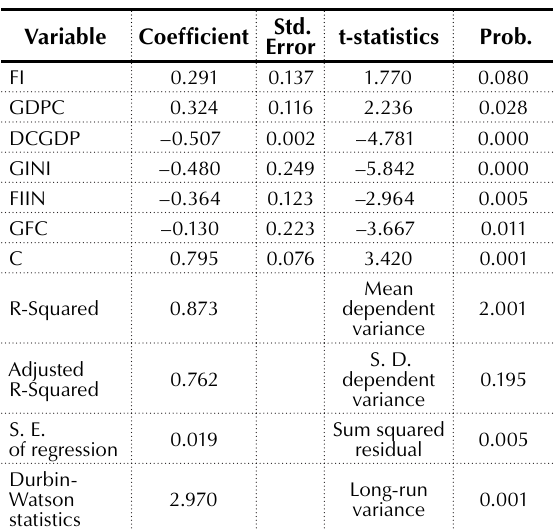
Table 6. Results of FMOLS regression